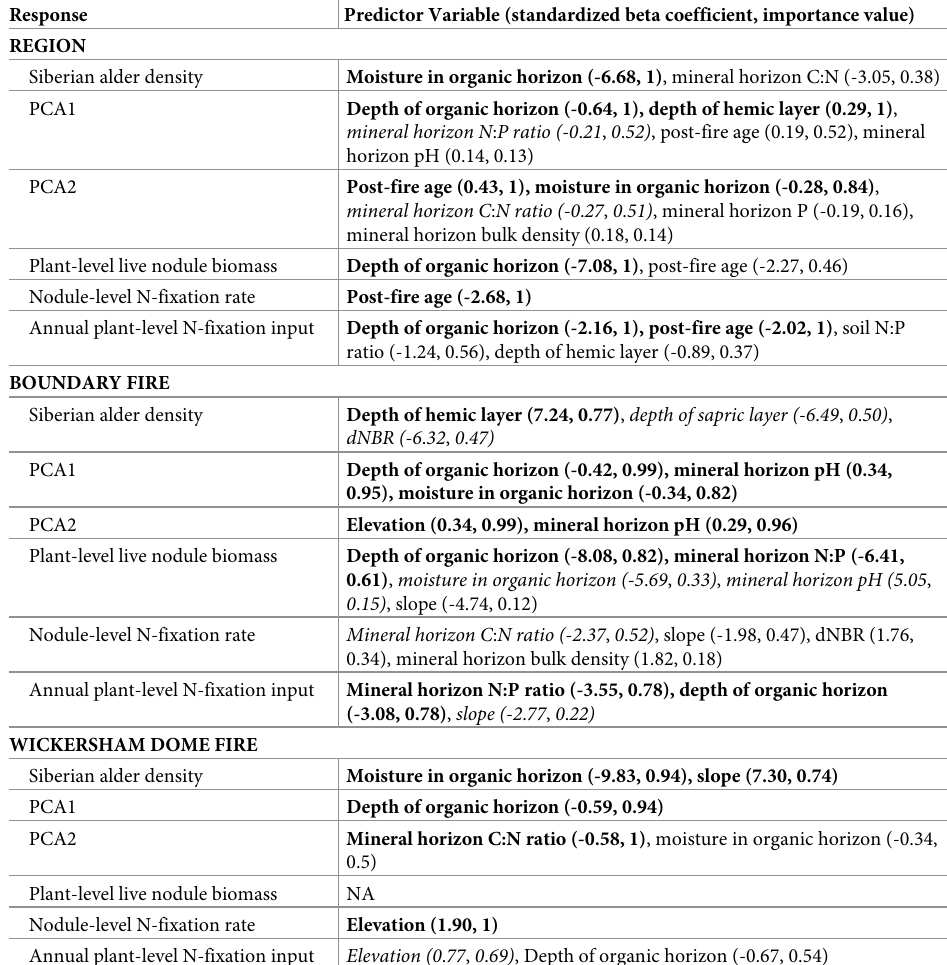
Table 2. Landscape models (AICc) for Siberian alder N-input and growth traits.